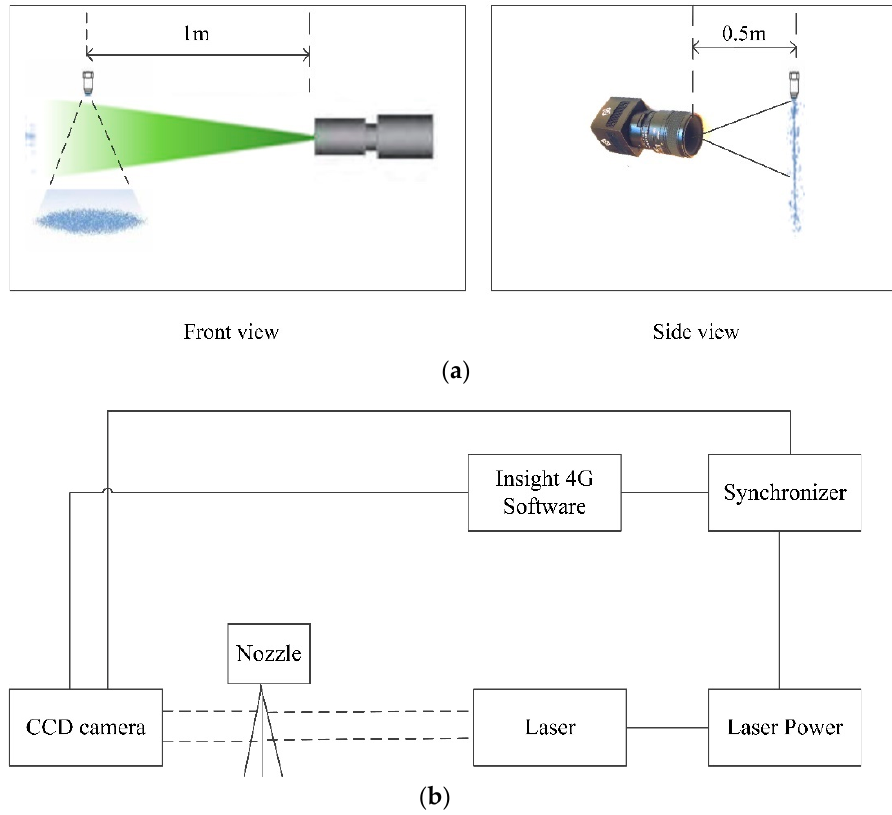
Figure 1. ( a ) Orientation diagram of the nozzle, laser, and camera. ( b ) Schematic diagram of the experimental layout for the measurement of liquid sheet breakup.